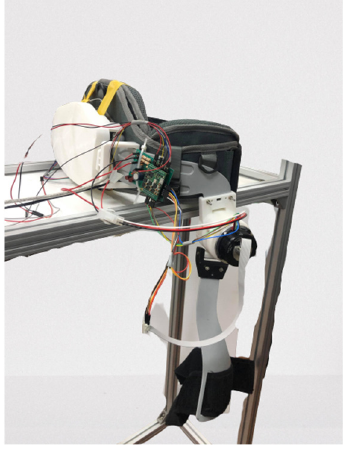
Figure 2. Robotic hip exoskeleton system building.